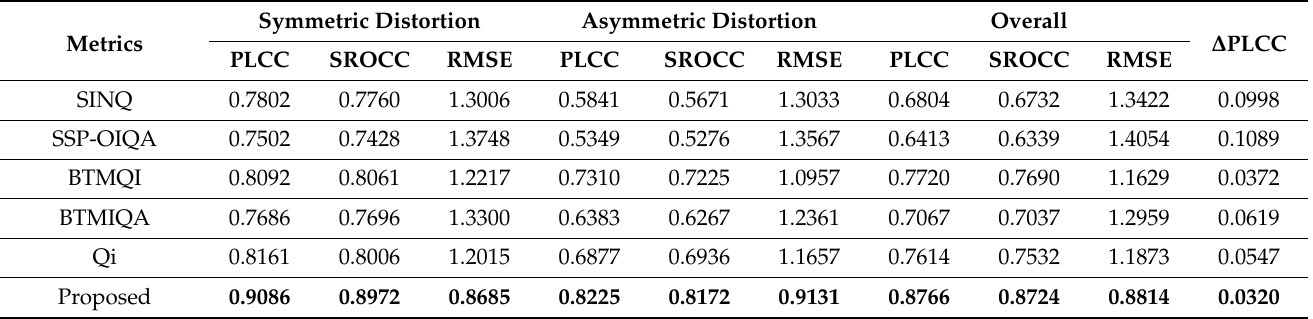
Table 8. Objective quality assessment results of symmetric/asymmetric distortions in the HSOID